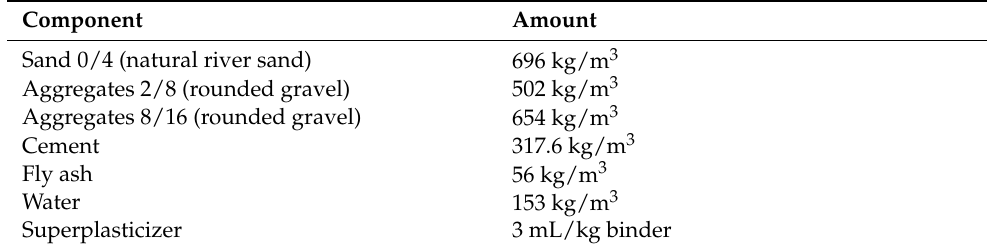
Table 1. Concrete composition.